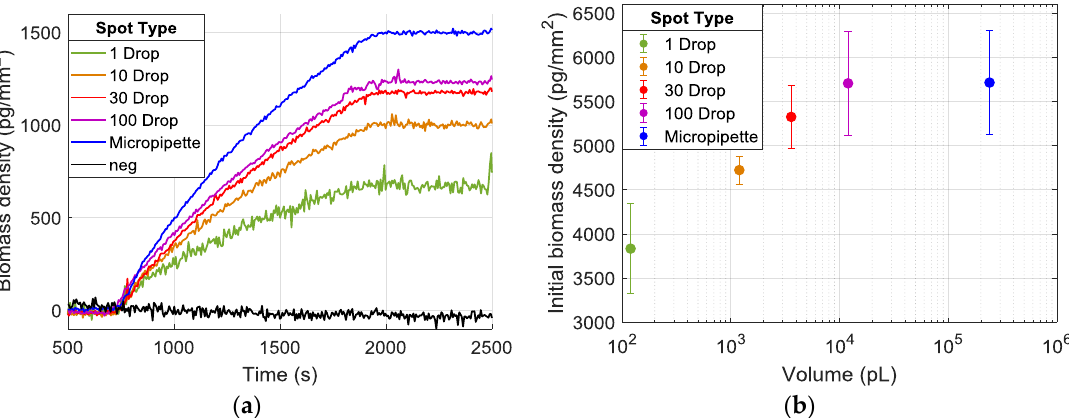
Figure 7. (a) Binding curves from spots created with dispensing 1–100 droplets and micropipette spots. Each curve is obtained from a single spot within its duplicates, having the median accumulation level. ( b ) The calculated thickness of spots and the corresponding volumes dispensed.